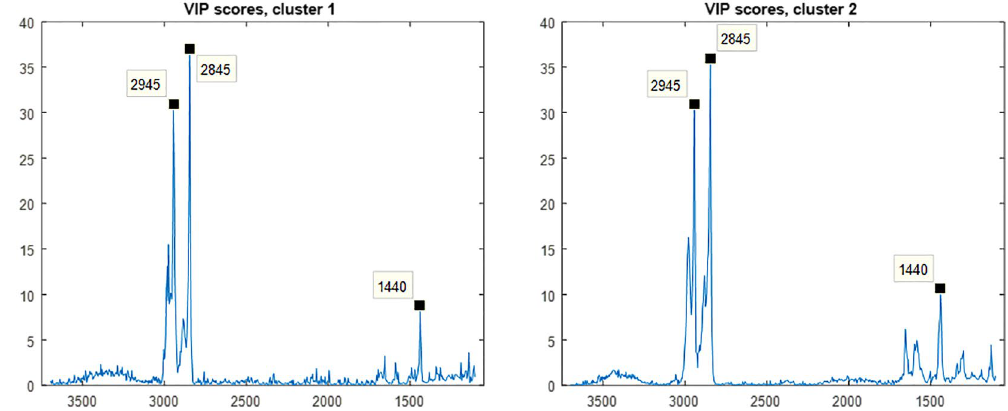
Figure 8. Variable Importance in Projection (VIP) scores for PLS-DA of K562 control and drug treated cells showing three Raman lipid